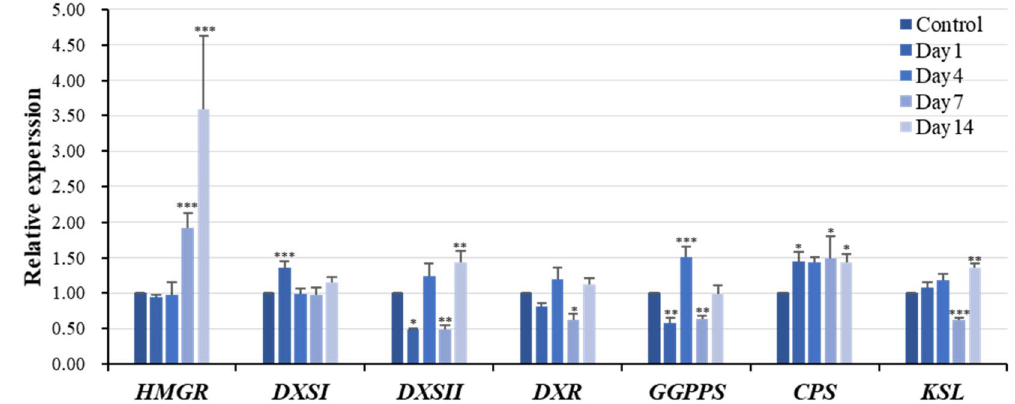
Figure 4. Gene expression of tanshinone-related compounds in Salvia miltiorrhiza hairy roots at 1, 4, 7, and 14 days under 75 μM 5-azacytidine treatment. The values were calculated by using ubiquitin as the endogenous control, following the 2 −ΔΔCt method. Bars represent the mean of relative expression ± S.E. of at least three